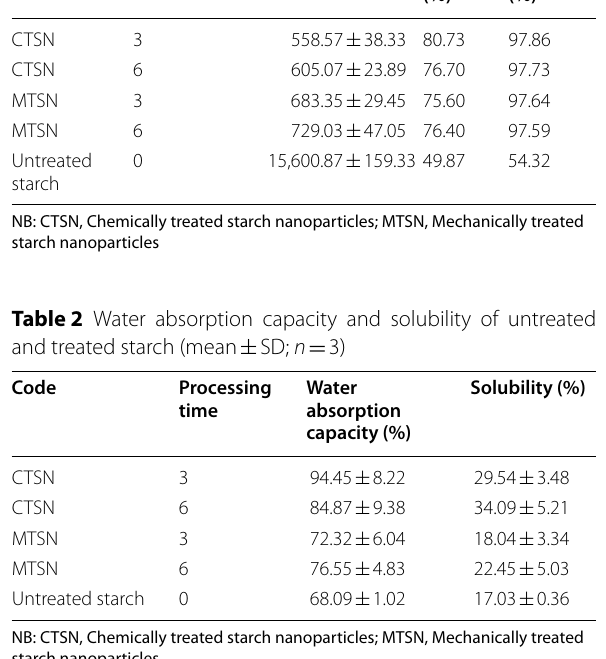
Table 1 Properties of ciprofloxacin-loaded untreated and treated potato starch